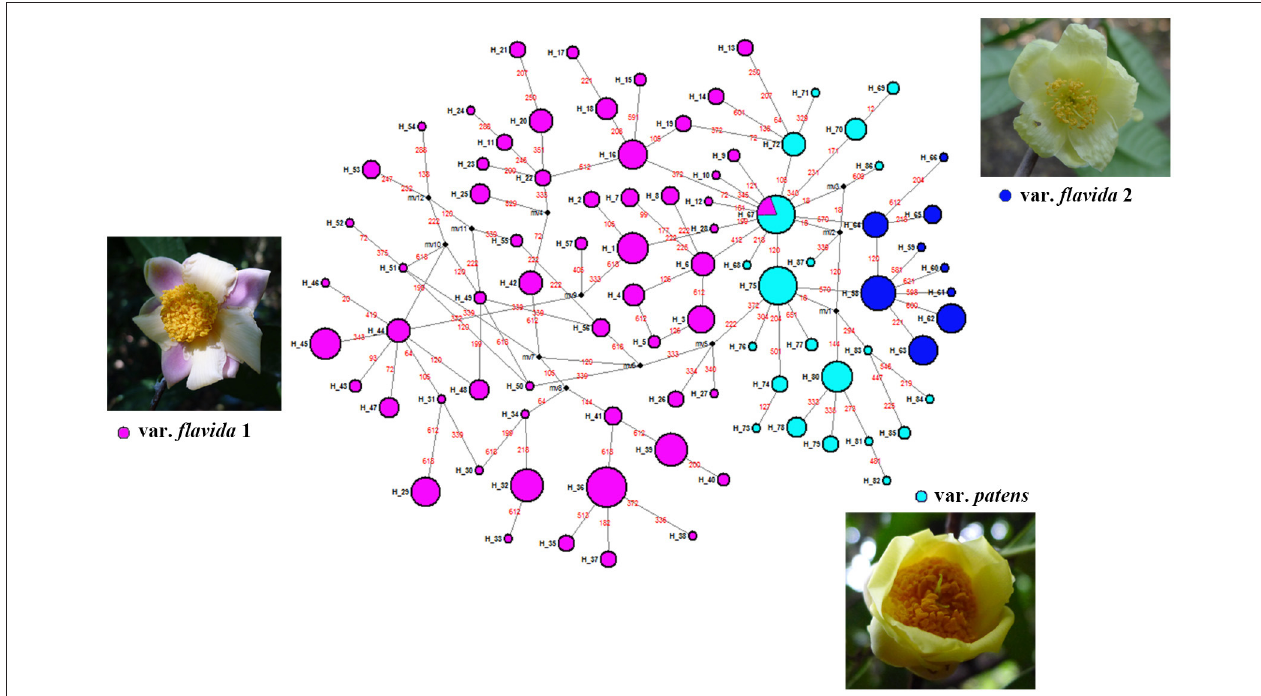
FIGURE 3 | Median-joining network for 87 PAL haplotypes and images of specimens of the three taxa identified in this study. Each haplotype is designated by a number H_1 to H_89 (see Table S2 ). Colors denote the groups as identified by SAMOVA analyses of PAL marker. Circle size is proportional to haplotype frequency. Missing haplotypes are represented by black dots, and mutations are shown in